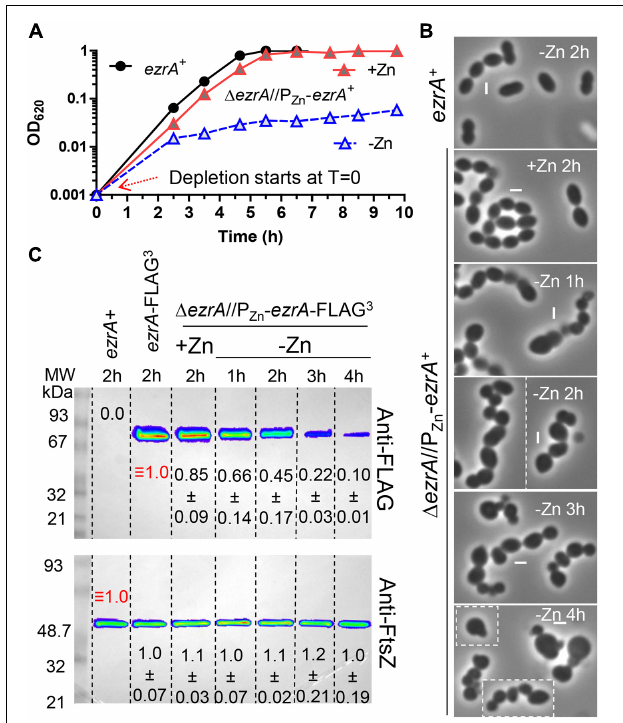
FIGURE 2 | Depletion of EzrA results in severe growth, size, and shape defects. EzrA depletion in untagged-strain, IU8799 ( (cid:49) ezrA // bgaA ::P Zn - ezrA + ) in (A) and (B) or tagged-strain, IU9572 ( (cid:49) ezrA // bgaA ::P Zn - ezrA -FLAG 3 ) in (C) . (A) Representative growth curves after resuspension in BHI broth containing or lacking ZnCl 2 show EzrA-depletion results in bacteriostatic-like growth. IU8799 and IU1945 (WT parent) were grown exponentially in BHI broth supplemented with 0.5 mM ZnCl 2 and 0.05 mM MnSO 4 to OD 620 ≈ 0.1, spun, and resuspended to OD 620 ≈ 0.001 for this growth curve. (B) Representative PCm images of wild-type (IU1945) or EzrA depletion strain (IU8799) after resuspension in BHI broth supplemented with, or lacking supplemented ZnCl 2 for 1, 2, 3, or 4 h. Resuspension volumes were adjusted in BHI broth supplemented with or without 0.5 mM ZnCl 2 and 0.05 mM MnSO 4 to OD 620 ≈ 0.36 (for T = 1 h time-point) or 0.012 (for T = 2, 3, and 4 h time-points). Experiments were performed three times with similar results. See Supplementary Figure 8 for quantitation. (C) Representative western blots of gels containing extracts of IU1945 (wild-type), IU5456 ( ezrA -FLAG 3 ), or IU9572 ( (cid:49) ezrA //P Zn - ezrA -FLAG 3 ). Western blotting using anti-FLAG antibody or anti-FtsZ are described in section “Materials and Methods” and Supplementary Materials . Protein amounts of ZnCl 2 -induced and ZnCl 2 -depleted strains relative to IU5456 ( ezrA -FLAG 3 native) for EzrA-FLAG 3 levels or IU1945 (untagged parent isolate) for FtsZ, levels were quantified and are from at least 3 independent biological replicates experiments ( ± standard